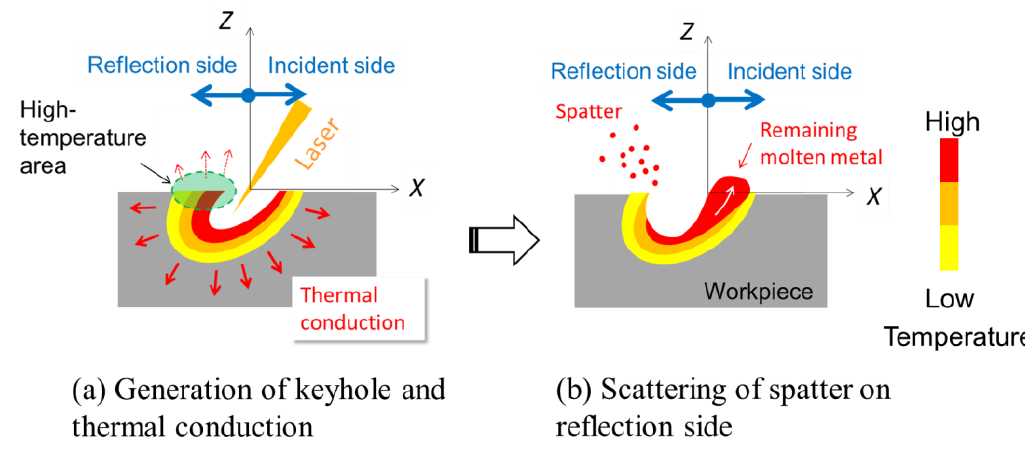
Figure 7. Schematic illustrations of temperature distribution and spatter during angled laser irradiation.